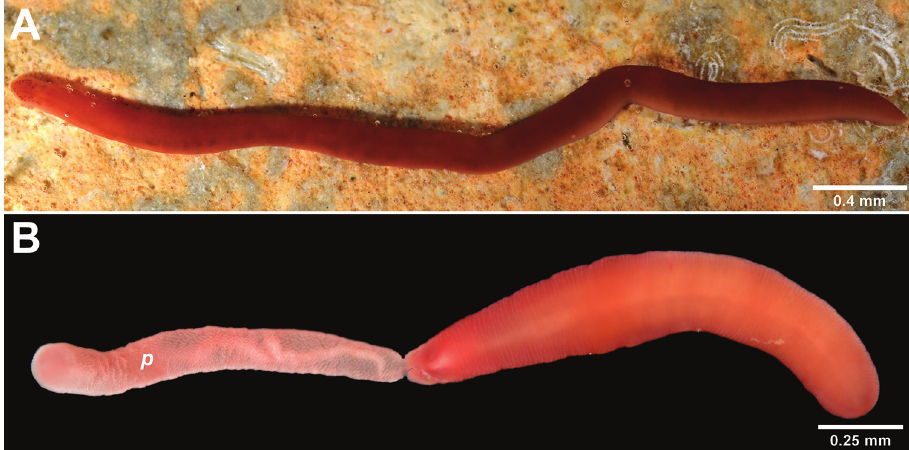
Figure 1. Nipponnemertes incainca sp. n. A Dorsal view of entire worm B Ventral view of entire worm. Abbreviation: p